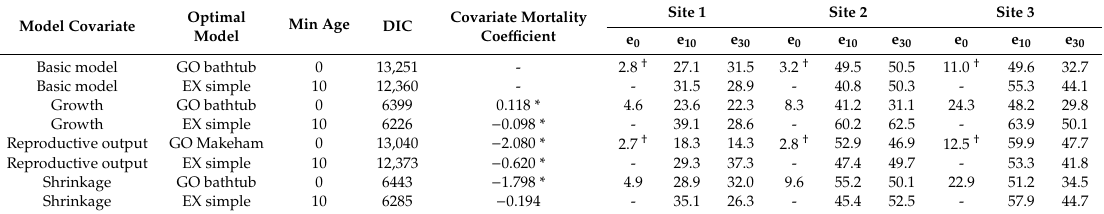
Table 2. Best-fitting Bayesian survival trajectory (BaSTA) models for each site and covariate of P. vulgaris spp. gotlandica , from germination and maturity. DIC = Deviance Information Criterion, e x = life expectancy for plants x years